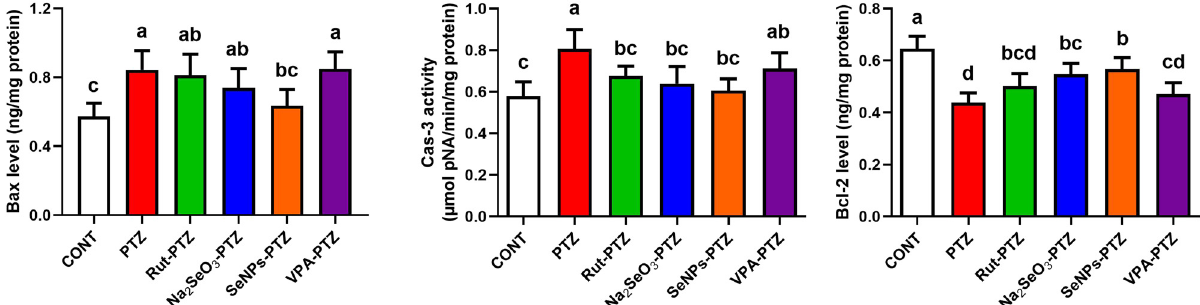
Figure 7: E ff ects of orally administered Rut, Na 2 SeO 3 , or Rut - SeNPs on the levels of pro - apoptotic markers ( Cas - 3 and Bax ) and anti - apoptotic marker ( Bcl - 2 ) in the hippocampus of PTZ - injected epileptic mice. Di ff erent superscript letters indicate statistical signi fi cance at P < 0.05. All results are presented as the mean ±